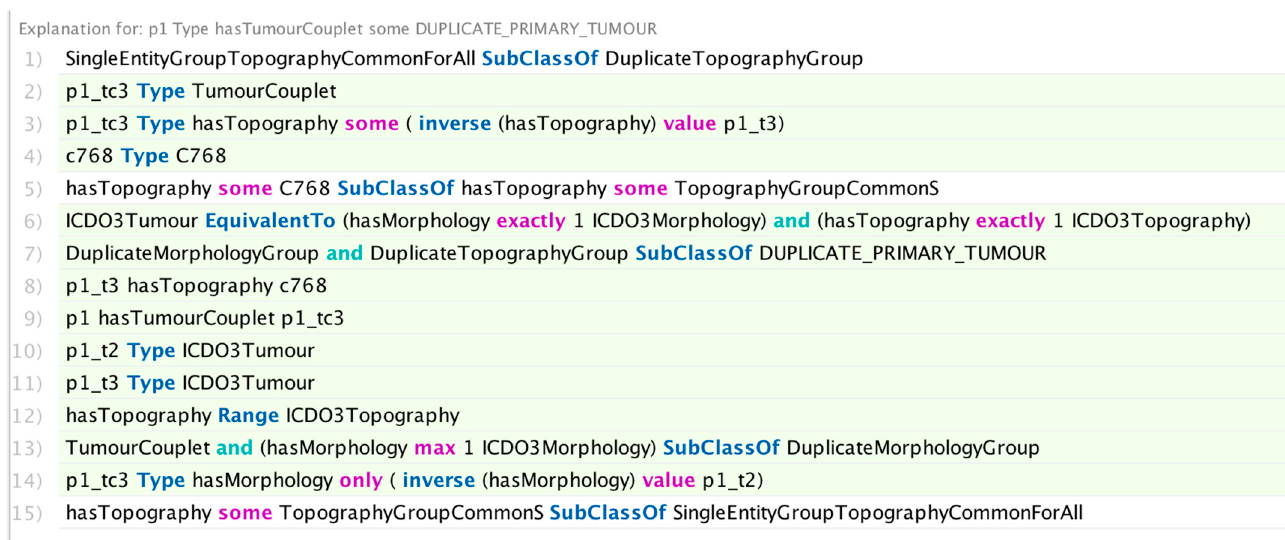
15 of 29 Figure 11. Results of a DL query for entities that have duplicate primary tumours. Figure 12 shows the explanation provided by the reasoner for the case of patient p1 (which is in effect the situation depicted in Figure 5), where it has been found that: (a) one of the topography codes C768 in the tumour couplet is in the group common to all other topography groups and therefore a duplicate topography group condition, c.f. Axiom (4) and lines 5, 15, and 1 in Figure 12; (b) the morphology codes in the tumour couplet are identical since there is only one morphology code and therefore a duplicate morphology condition, c.f. Axiom (7) and lines 2, 14, and 13 in Figure 12;